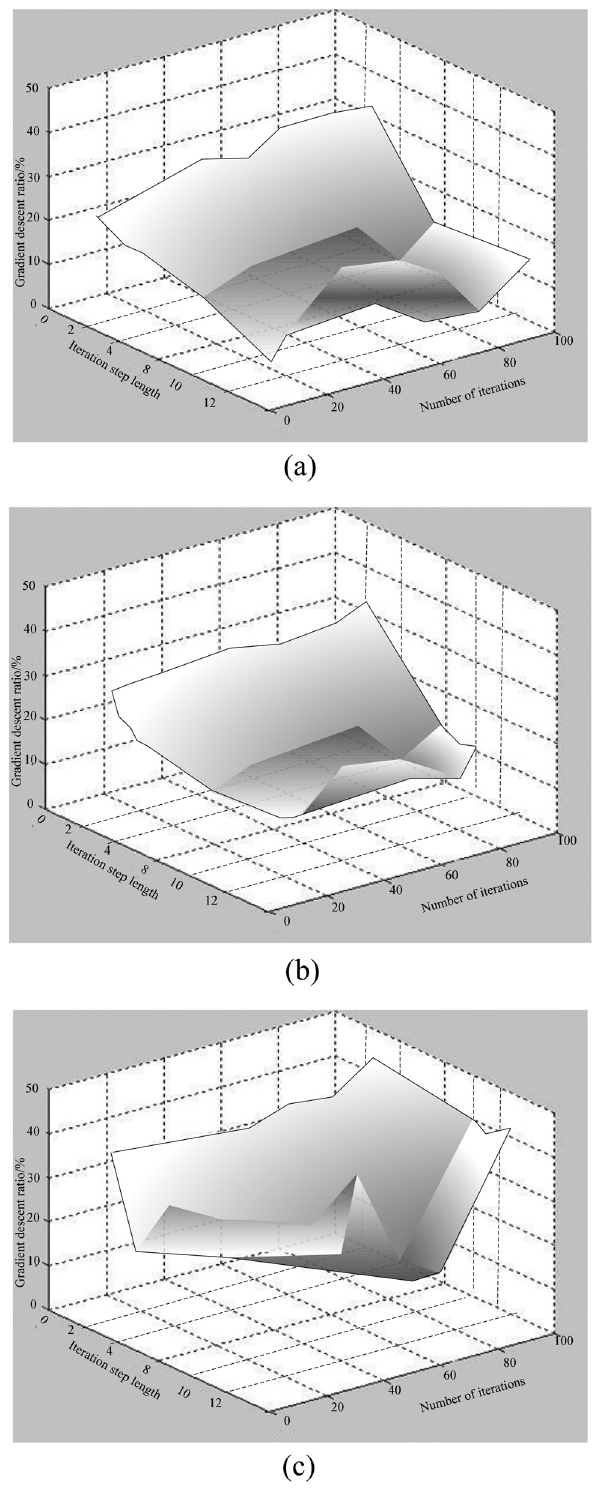
Figure 2: Algorithm learning rate comparison results: ( a ) support vector machine algorithm, ( b ) k - means clustering algorithm, and ( c ) FCM clustering